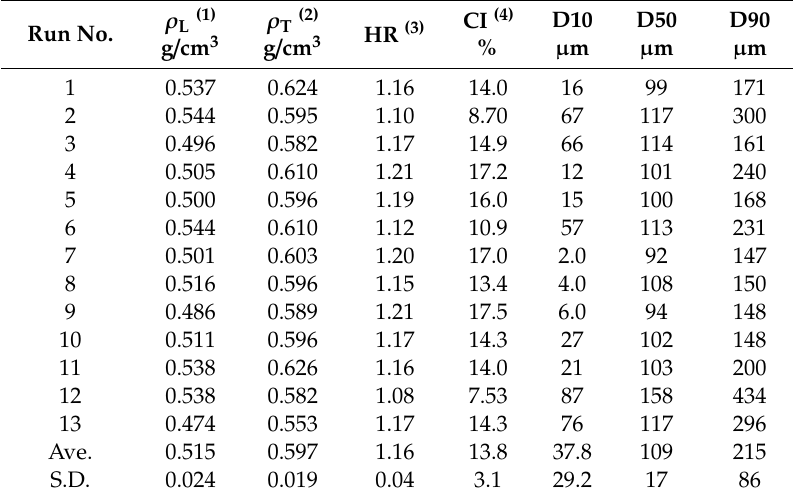
Table 4. Physical attributes of prepared